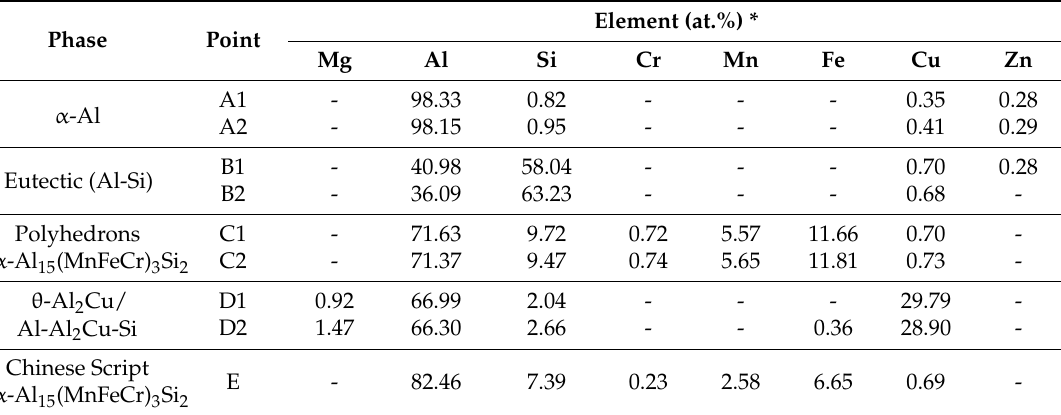
Table 2. MEV-EDS chemical composition of the points presented in Figure